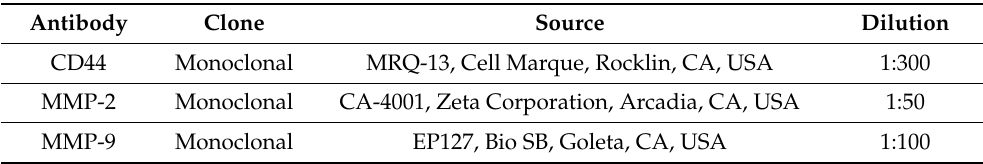
Table 8. Details of the primary antibodies used for immunohistochemistry.